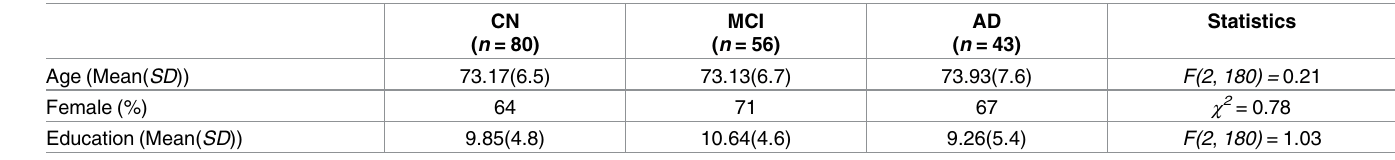
Table 2. Demographic characteristics of the second